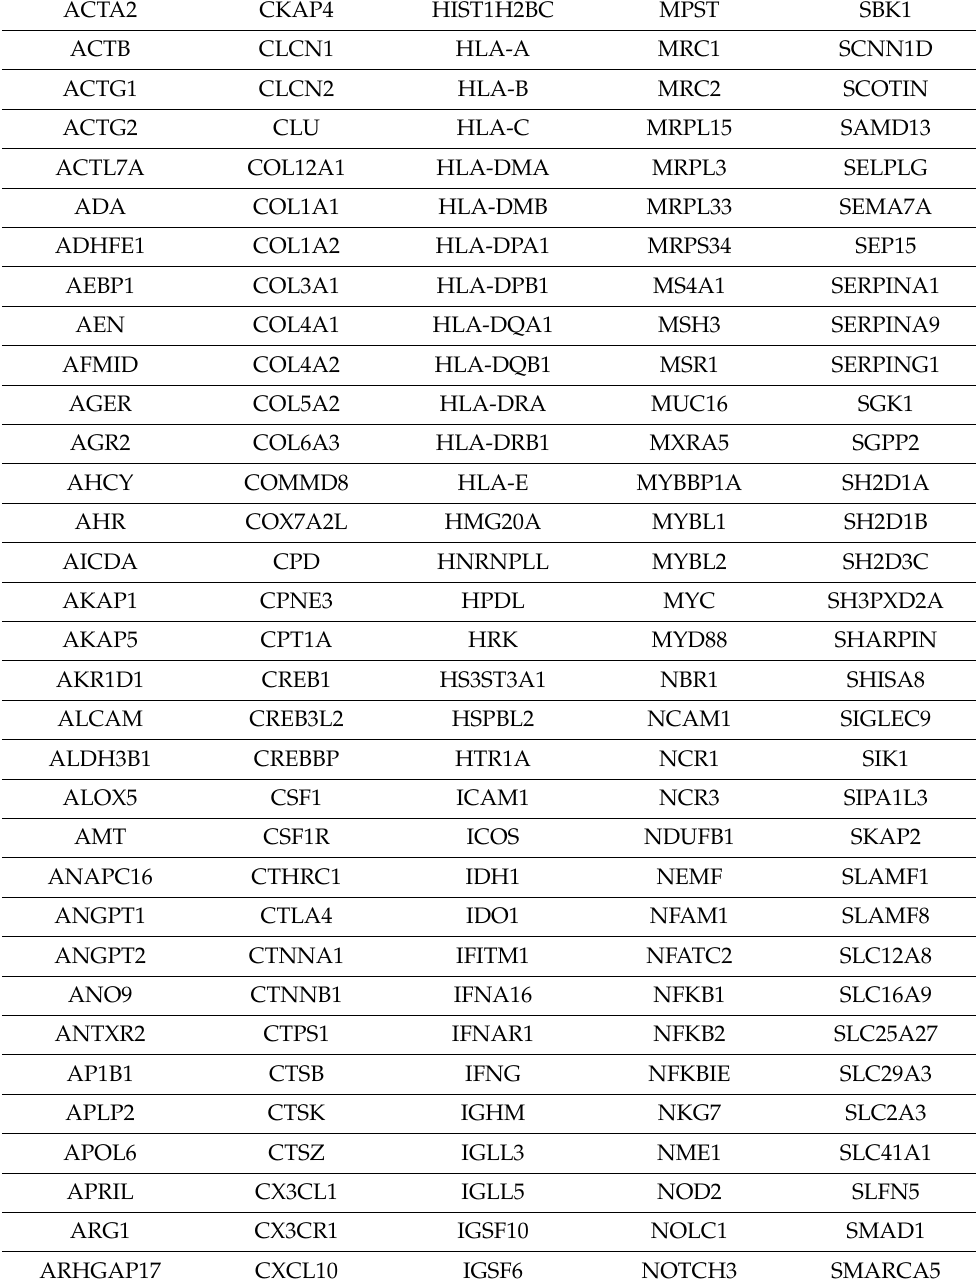
Table A1. A proposal for a consortium gene-expression profiling panel: